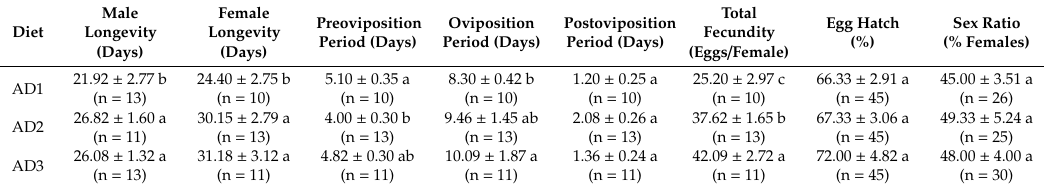
Table 3. Mean ± SE adult longevity, female periods, fecundity, egg hatching, and the sex ratio of S. gilvifrons fed on three di ff erent artificial diets.